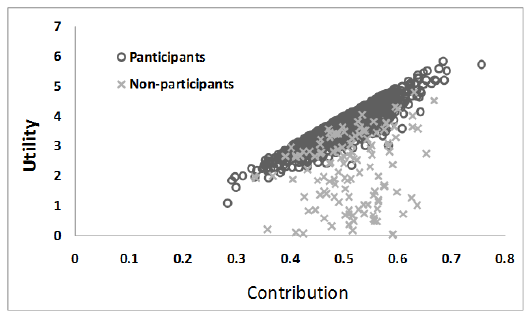
Fig. 3. Distribution of utility versus contribution for participants and